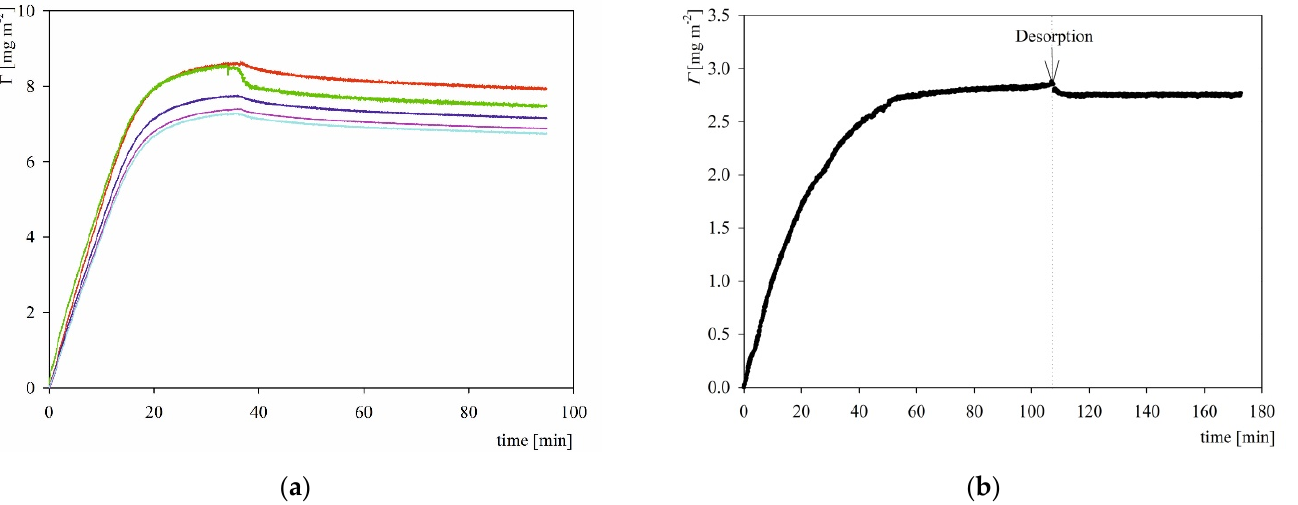
Figure 7. Kinetics of S1R adsorption/desorption expressed as the dependence of the coverage on the time. Experimental conditions: pH 3.5-4, electrolyte concentration 10 mM, bulk protein concentration 5 mg L − 1 flow rate 8.3 × 10 − 4 cm 3 s − 1 . Part ( a ) QCM measurements, silica sensor; the coverage was calculated using the Sauerbrey equation for the overtones 3 (red), 5 (green), 7 (blue), 9 (violet), 11 (light blue). Part ( b ) OWLS measurements, silica sensor.